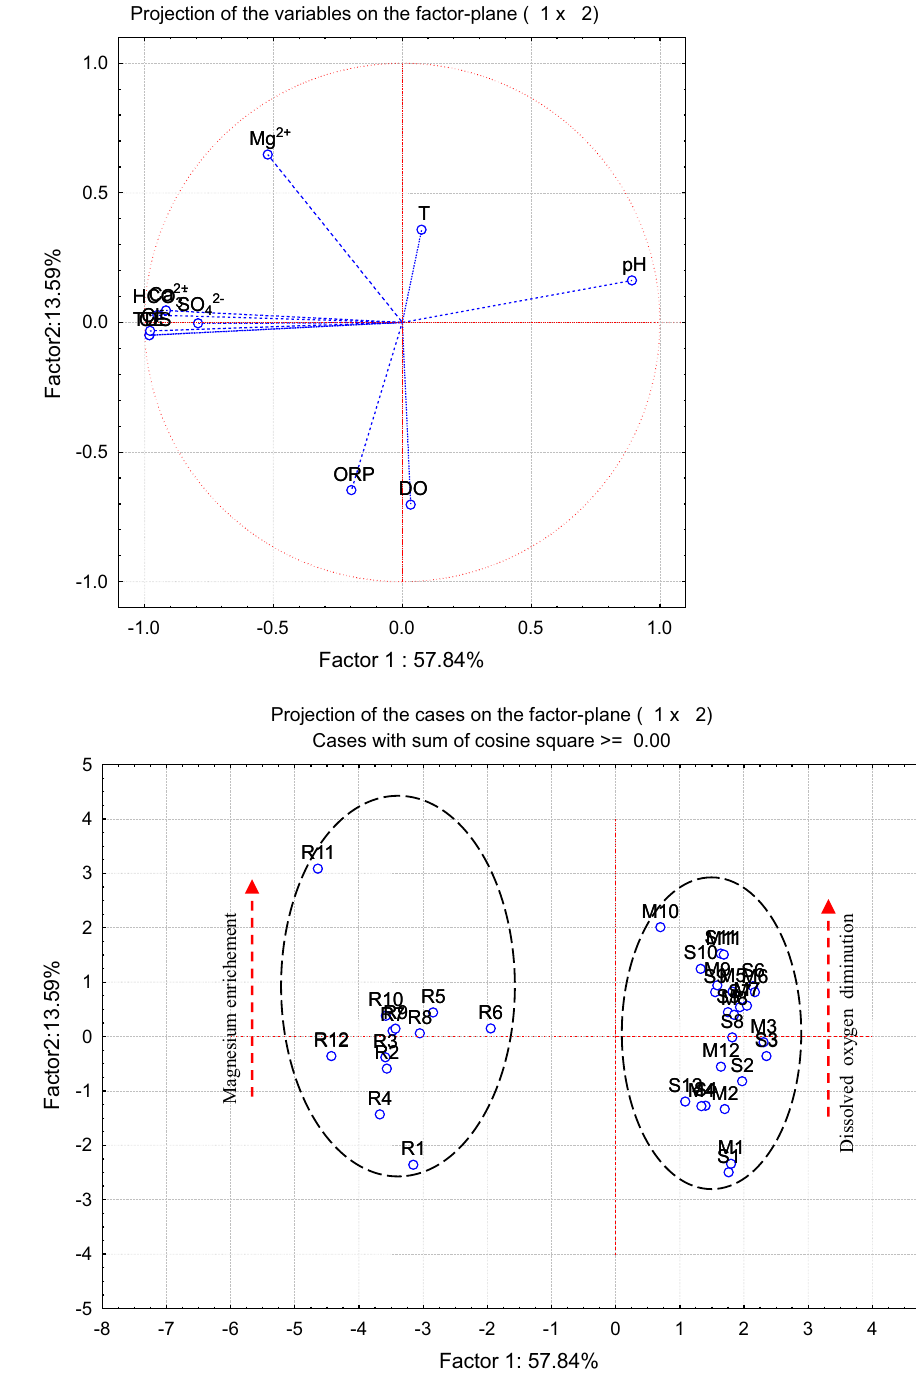
Projection of the variables on the factor-plane ( 1 x